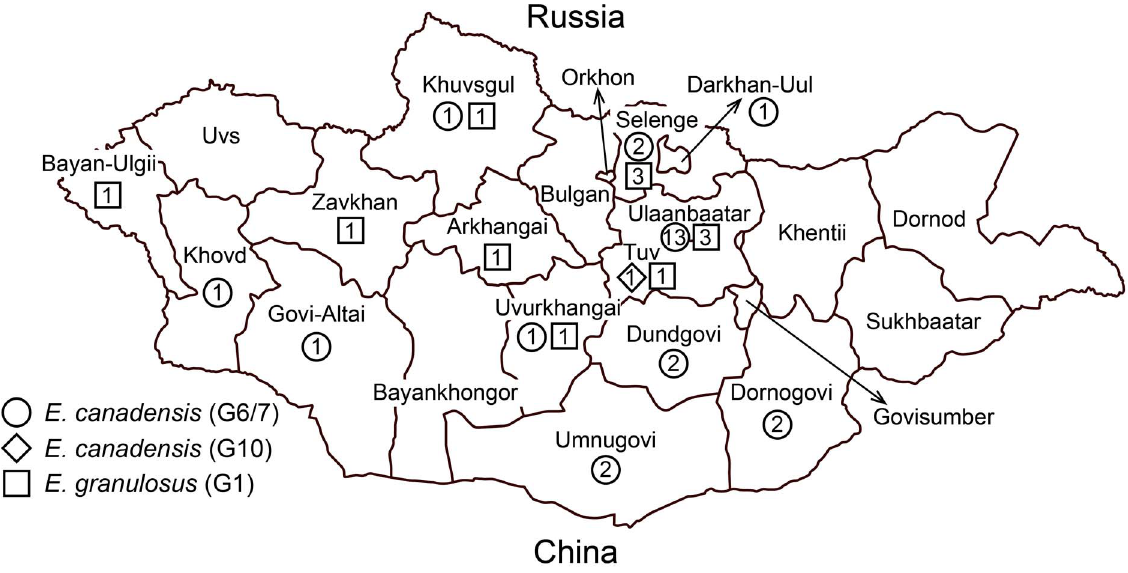
Figure 2. A map of Mongolia showing the distribution of 39 CE cases caused by E.canadensis (G6/7) (n=26), E.canadensis (G10) (n=1), and E.granulosus s.s. (G1) (n=12). Additional four cases had no record of province (see Table 1).